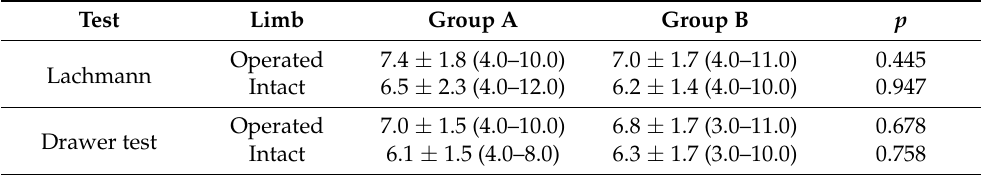
Table 4. Mechanical knee stability in ACL patients. Values are presented as mean ± standard deviation. The minimum and maximum values are given in brackets. p values are indicated.